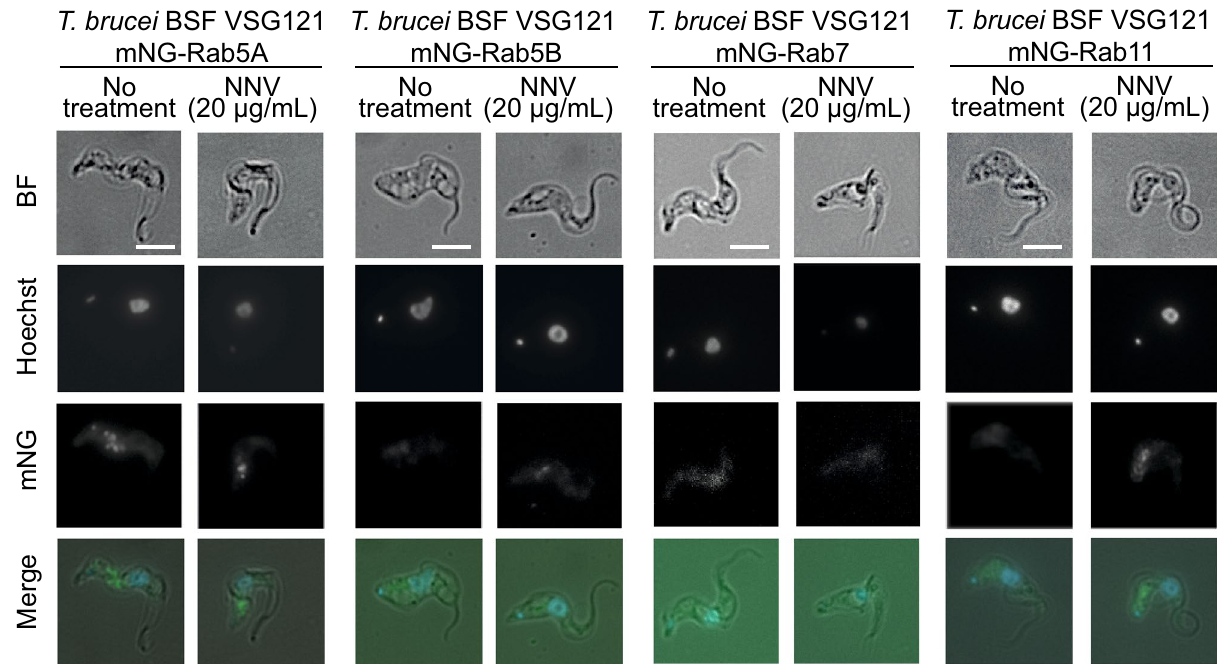
Figure 6. The downstream Rab11+ recycling endosome is likely affected by PLA 2 action. Fixed fluorescence microscopy (100X) was performed at 6 h post-NNV addition and no treatment conditions. 100 cells